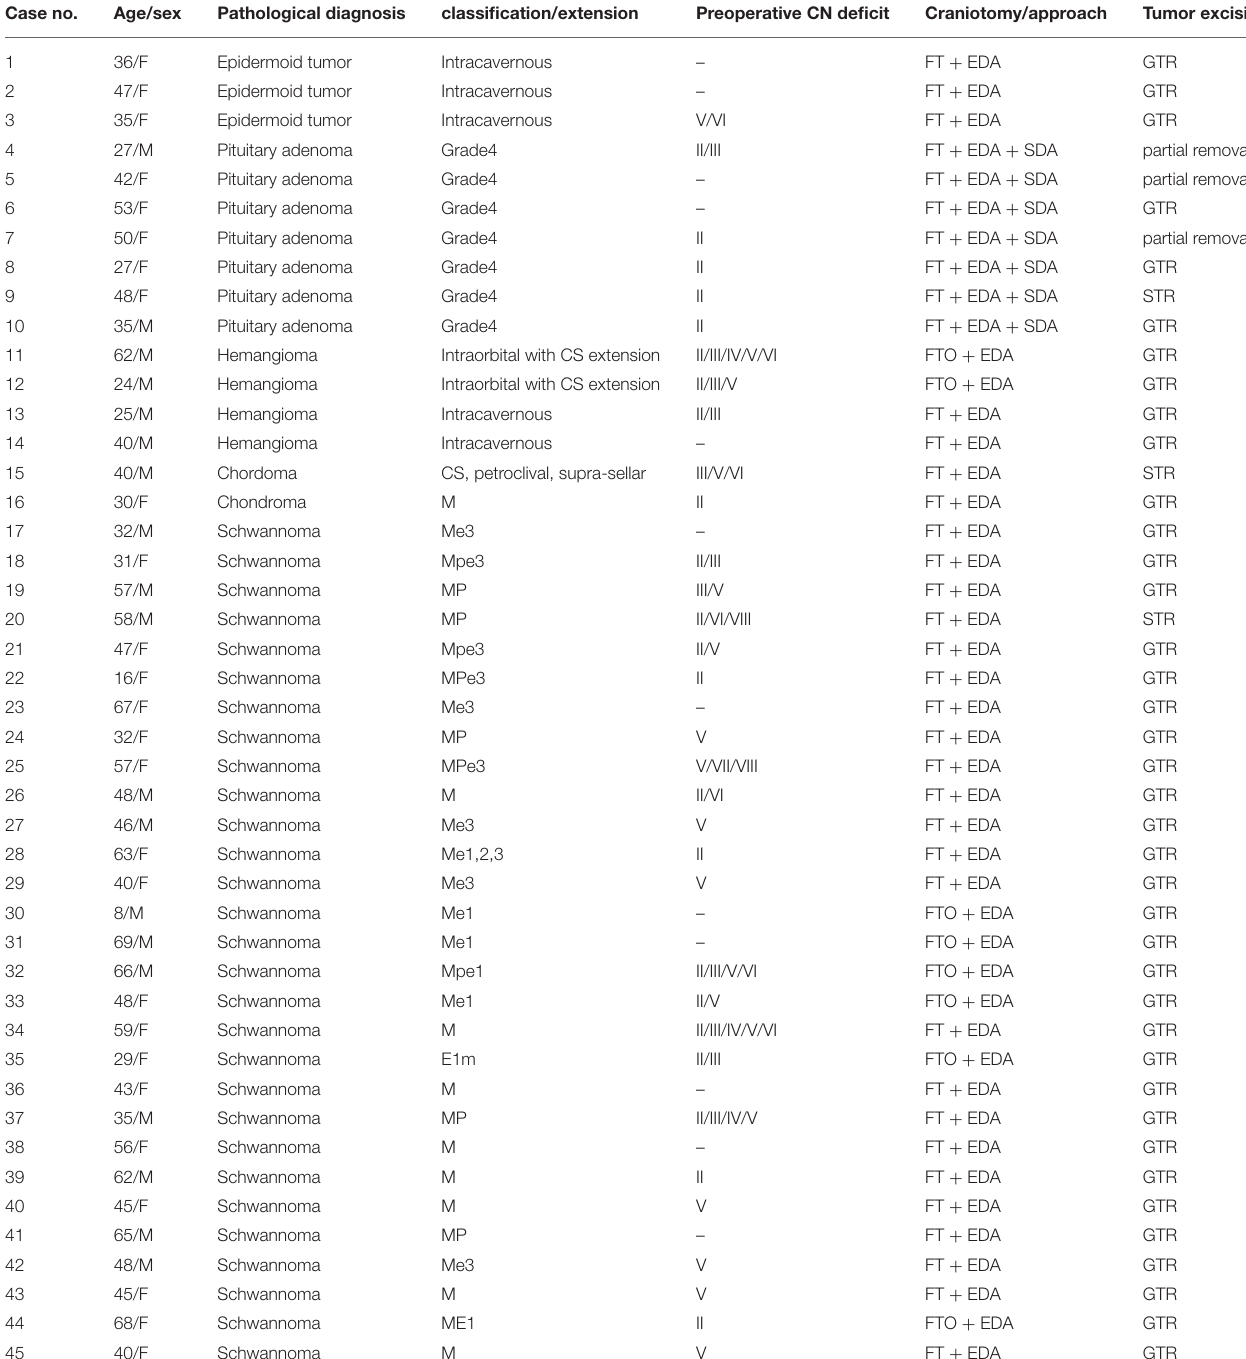
TABLE 1 | Characteristics of the study cohort. Case